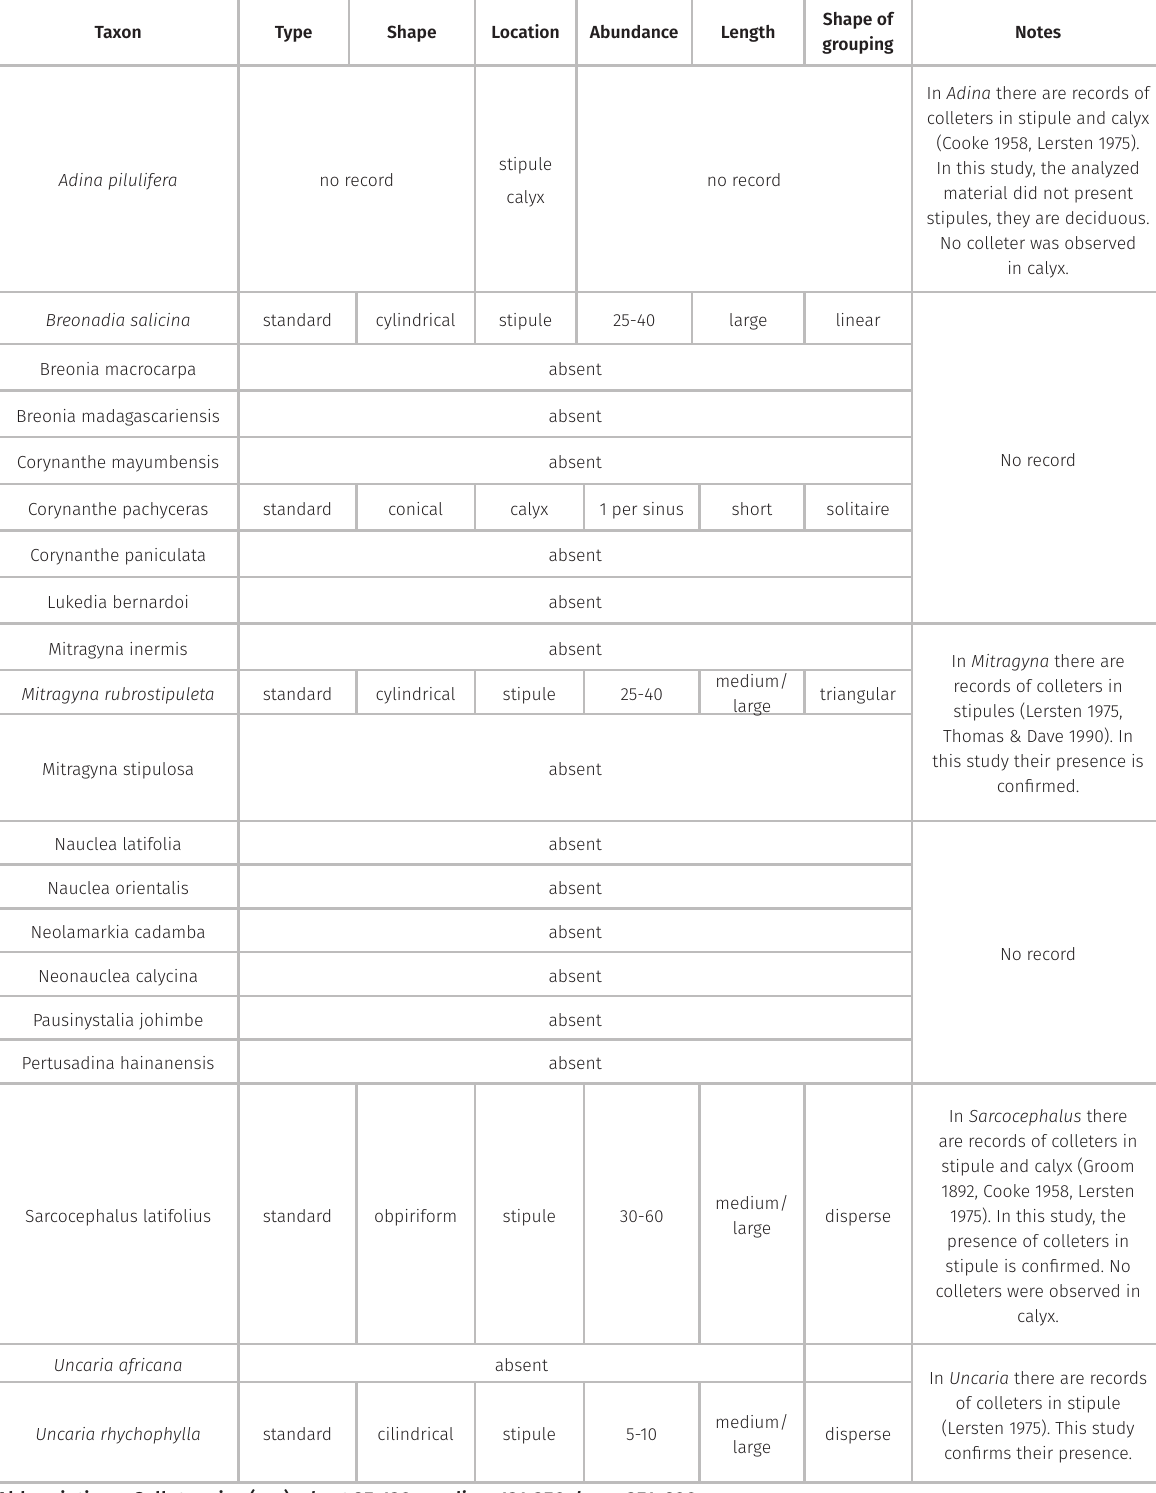
Table IV. Location and characteristics of colleters in species of the Naucleeae